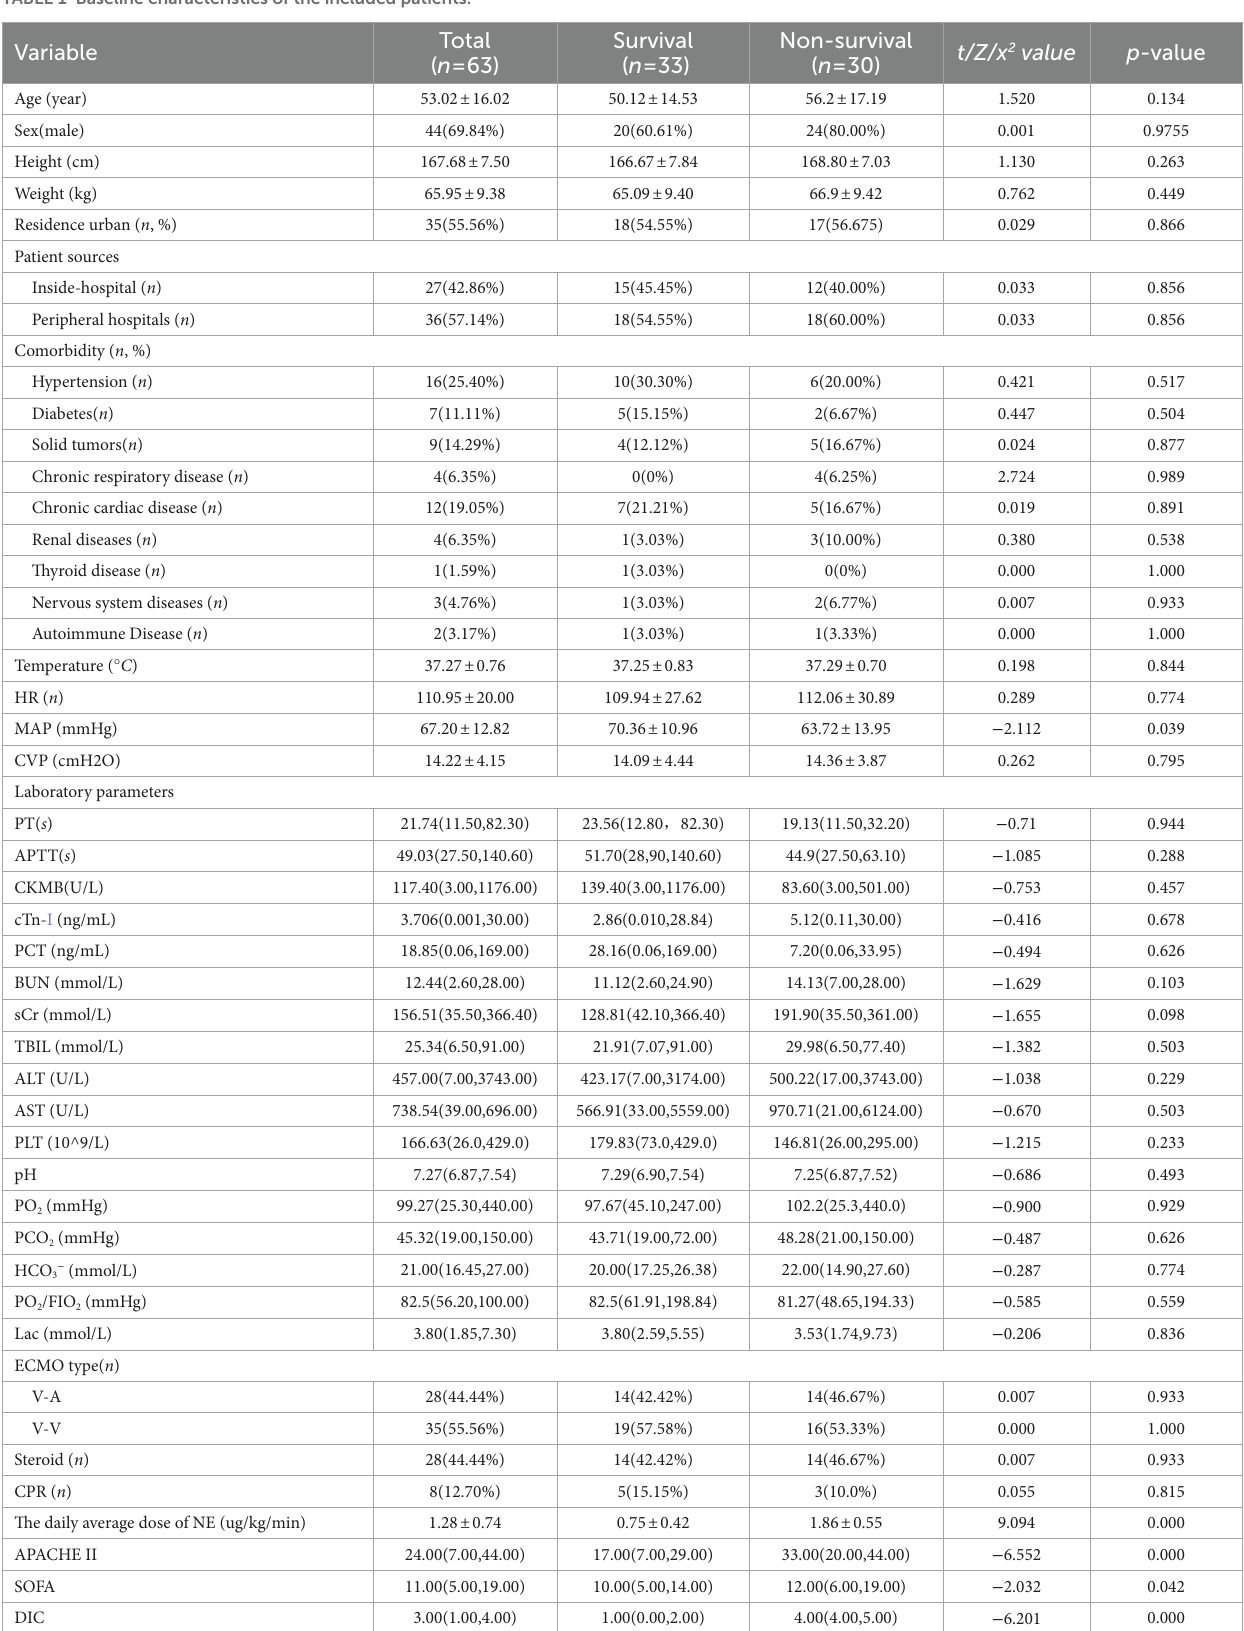
TABLE 1 Baseline characteristics of the included